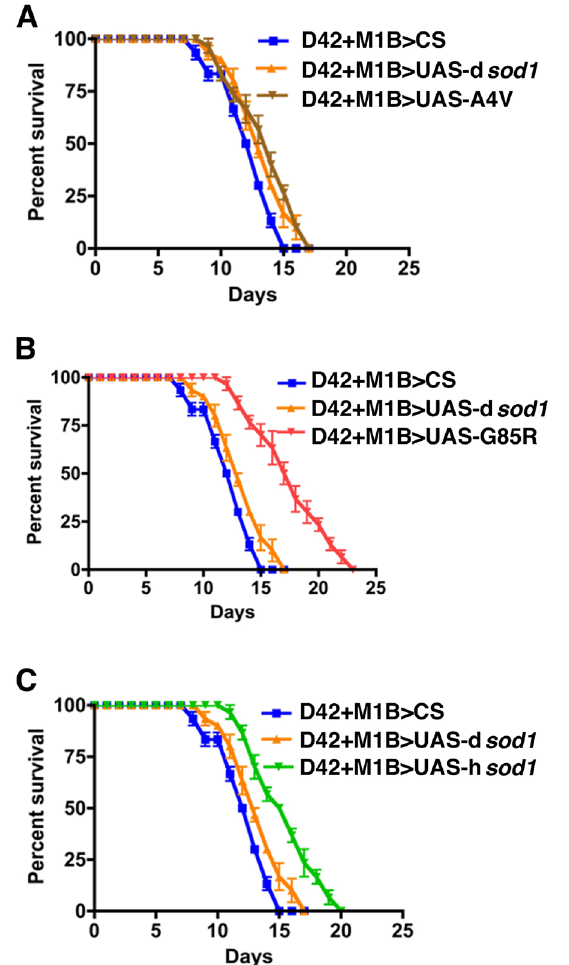
Figure S3. Human SOD1 co-overexpressed in motor neurons and glial cells and treated with 3 mM BMAA. Shown are survival rates of 35 day-old male sod1 transgenic flies under 3 mM BMAA treatment (10 flies per vial). Panels A , B and C represent flies expressing mutant human A4V, G85R, wild type SOD1 proteins. The 50% survival rate of A4V, G85R, and hSOD1 when compared with dSOD1 is increased by 8, 30, and 15%, respectively. Differences were considered statistically significant if p<0.01 and were calculated by a paired t-test method using Prizm software (n=30 for each genotype).